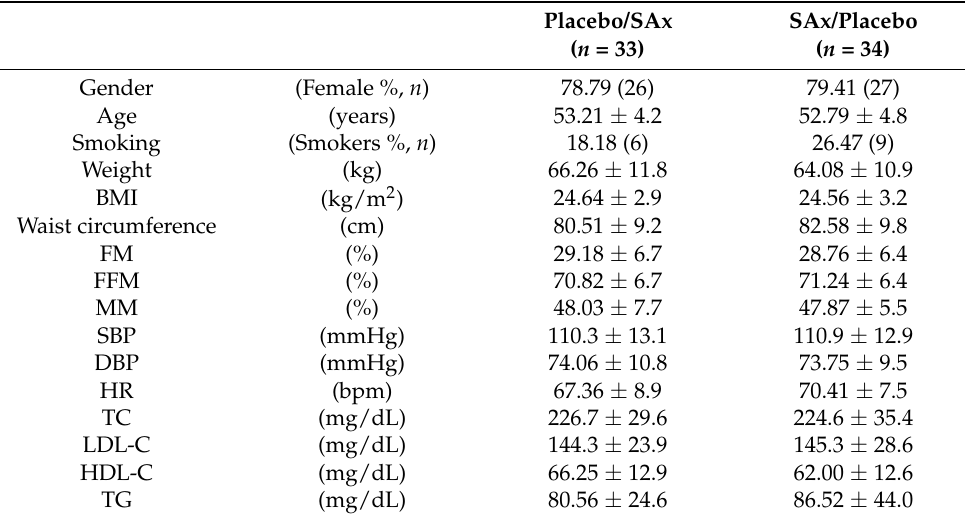
Table 1. Baseline characteristics of the participants.